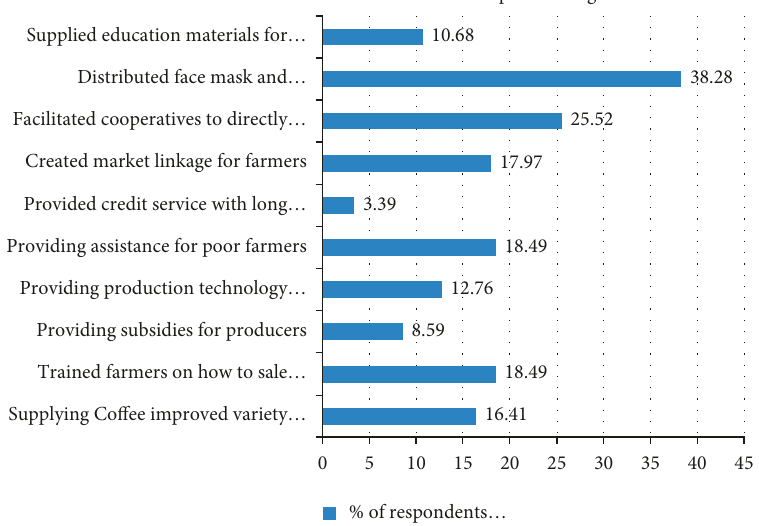
Figure 4: Measurements are implemented to overcome COVID-19